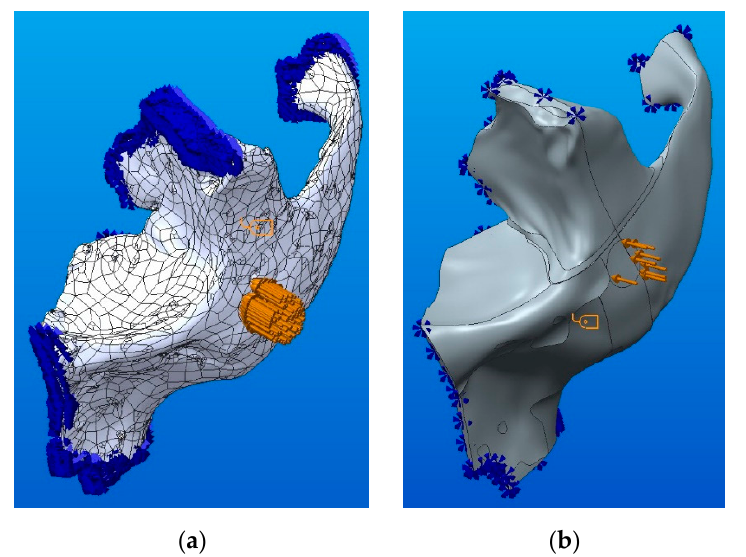
Figure 17. Loading conditions and kinematic constraints: ( a ) for the CATIA model; ( b ) for the Creo model. Table 1. Data referring to the mesh